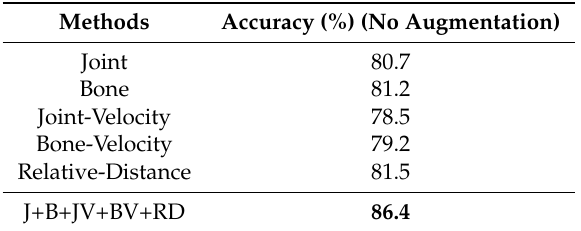
Table 3. Comparisons of the validation accuracy with different input modalities on cross-subject benchmark of NTU-RGBD-120